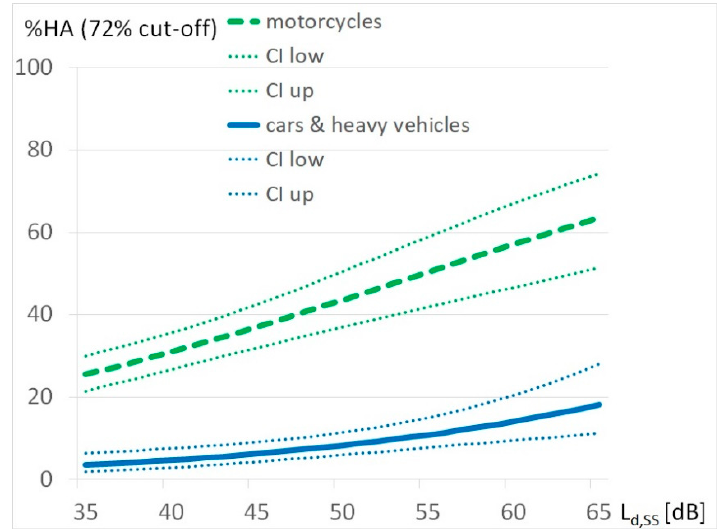
Figure 5. Exposure-response relationship % HA 72 for motorcycles and other vehicles (cars and heavy vehicles) adjusted by noise sensitivity and attitude to motorcycles by noise exposure during daytime on summer Sundays L d,SS